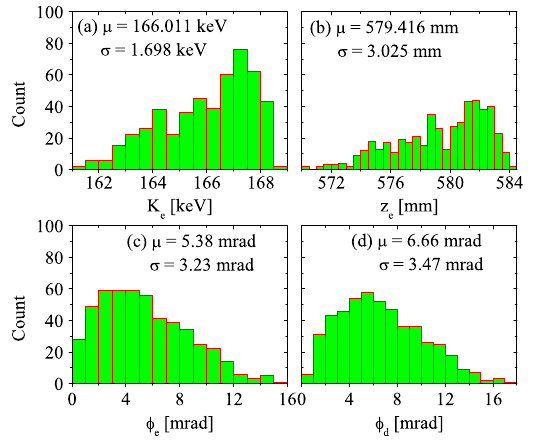
FIG. 3. Same as Fig. 2, but for a single C 6 þ ion. Integration time is 3.555 ns.